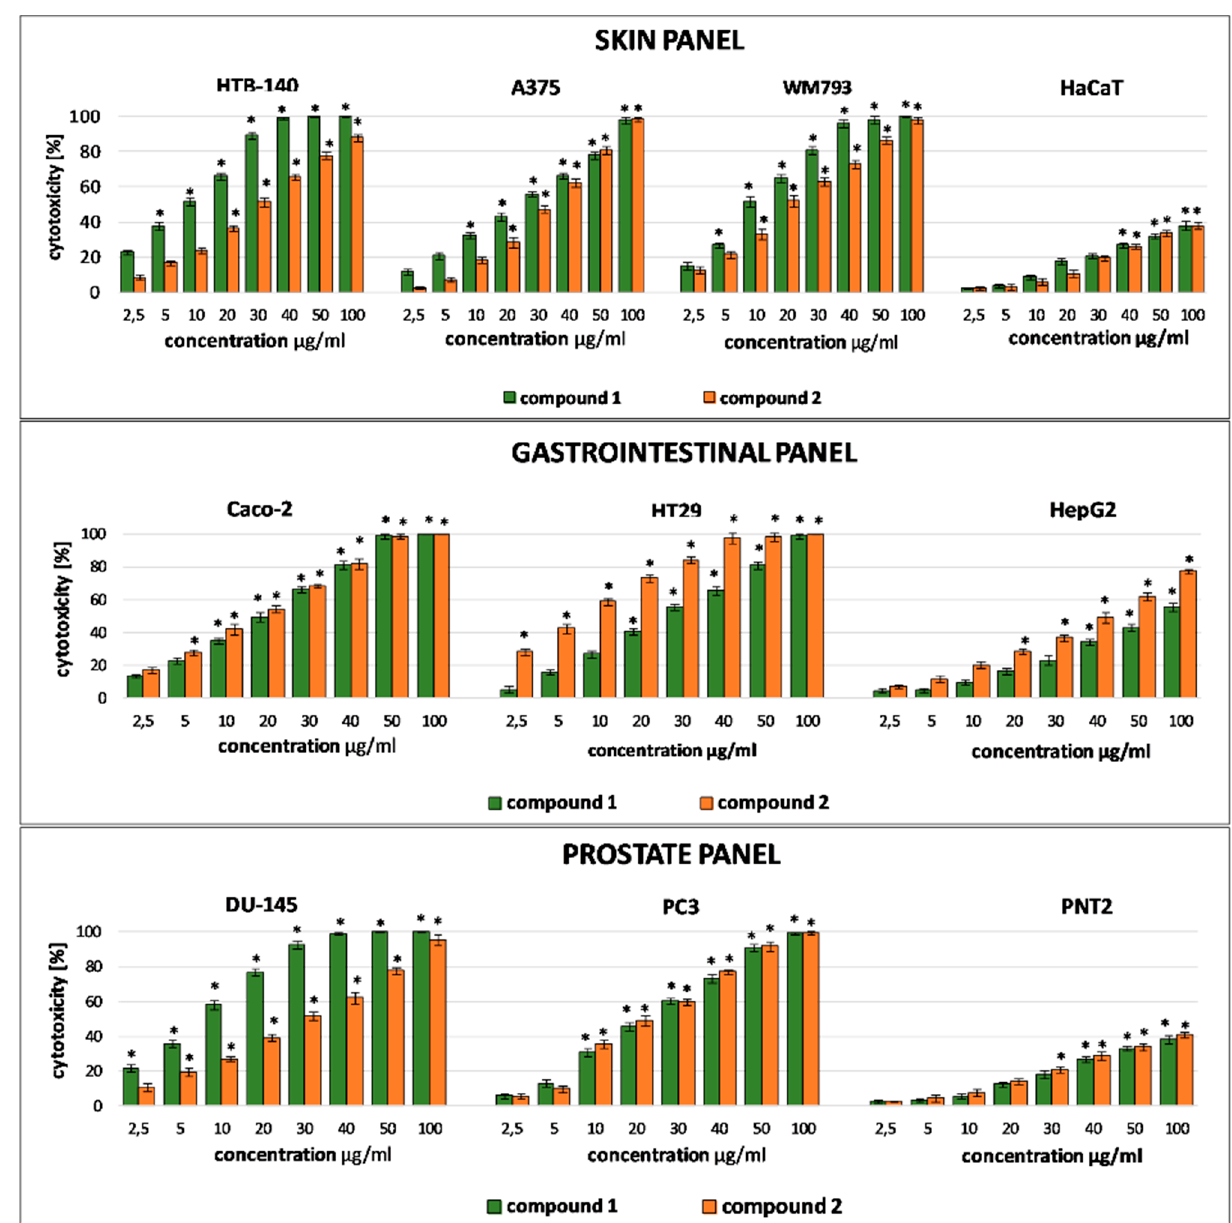
Figure 3. Cytotoxic activity of compounds 1 and 2 towards human cell lines, grouped into panels-skin panel: melanoma (HTB140, WM793, A375), keratinocytes HaCaT cells; gastrointestinal panel: colorectal adenocarcinomas (Caco2, HT29); hepatocellular carcinoma (HepG2); prostate panel: prostate carcinoma (DU145,PC3), normal prostate epithelial (PNT2). Results from the LDH viability assay after 24 h incubation with tested substances. Results are presented as the mean ± SD. The values significantly different from the control (untreated group) are indicated by * for p ˂ 0.05 (Mann–Whitney U test).